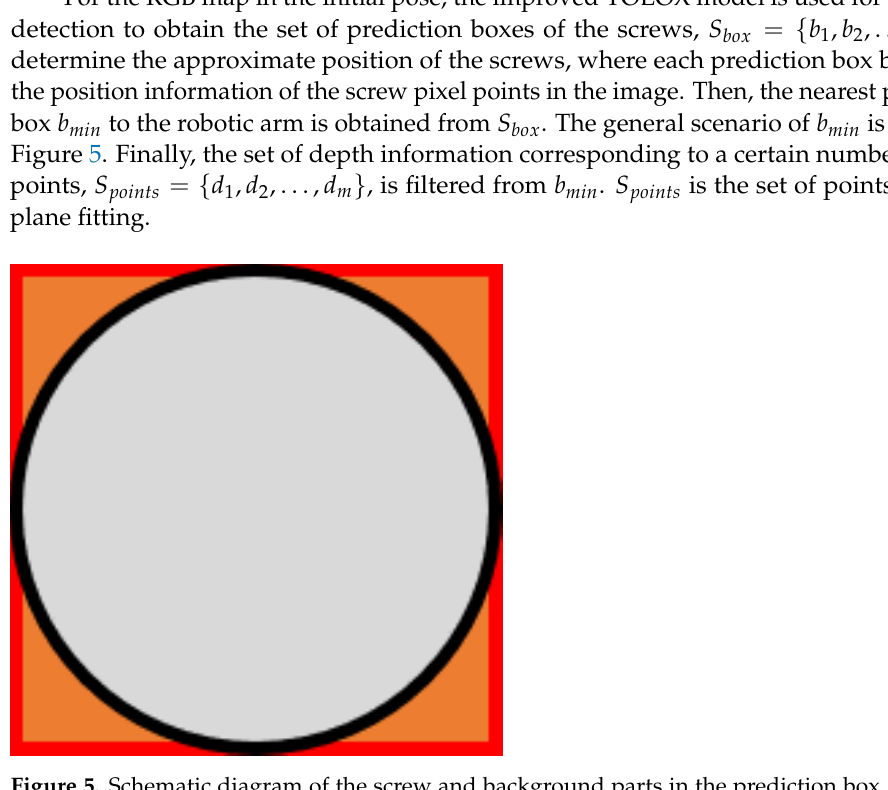
Figure 5. Schematic diagram of the screw and background parts in the prediction box, where the gray part is the screw body area, and the orange part is the background